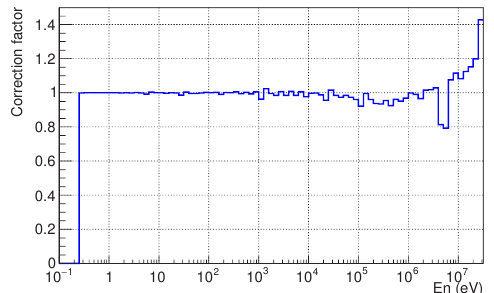
Figure 6: Correction factor for double-bunch mode as a function of neutron